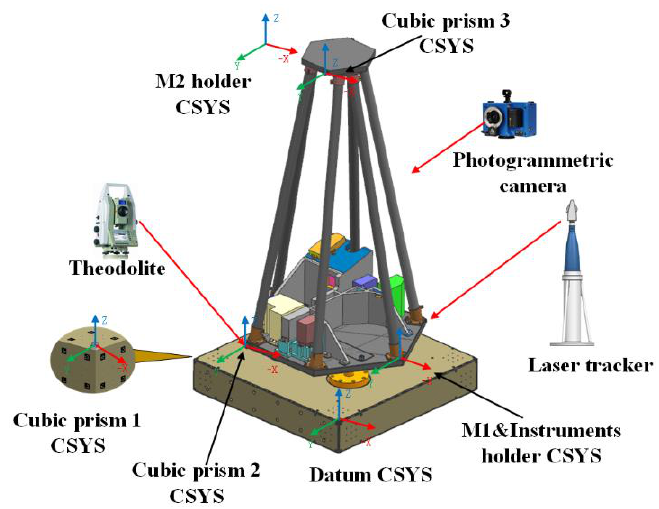
Figure 2. Definition of the measurement coordinate system.